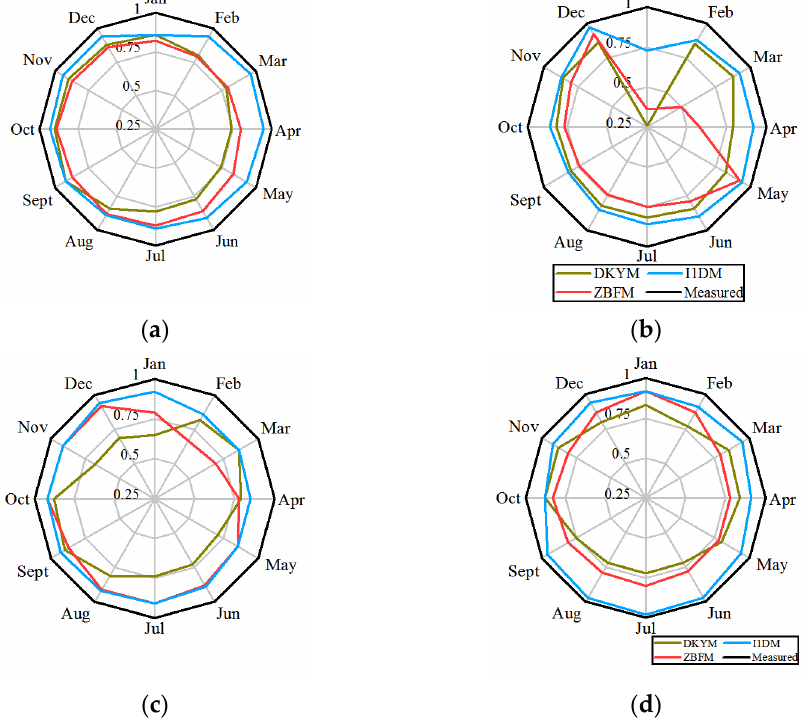
Figure 8. Comparison of precision coefficients for each month. ( a ) Xulong. ( b ) Xiluodu. ( c ) Jiexu. ( d ) Sanhekou. Table 4. Reservoir operating water level (altitude, m).